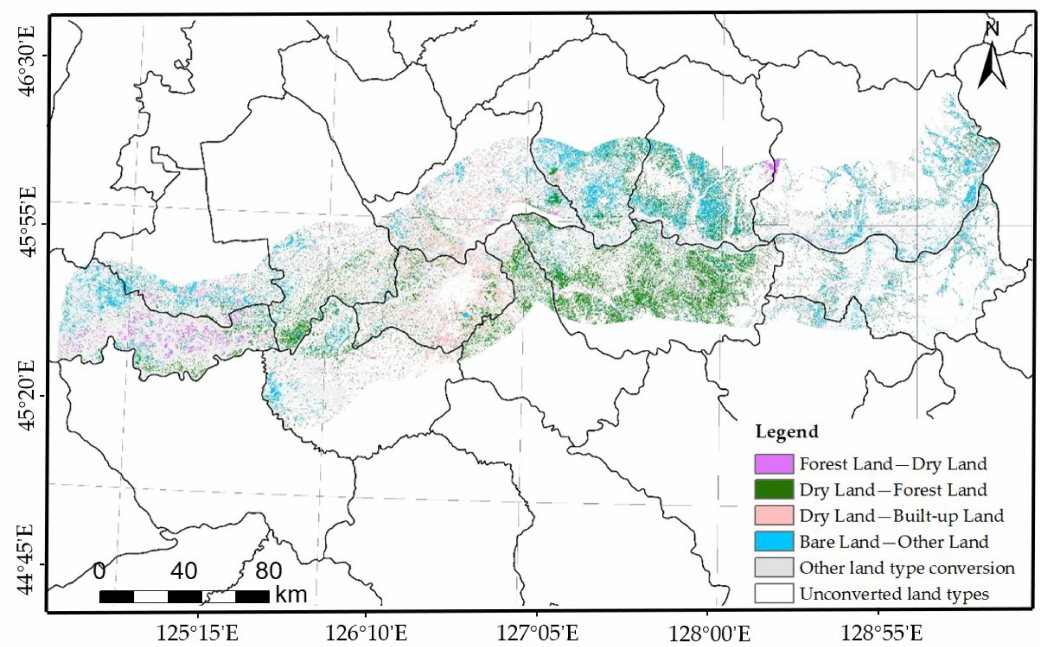
Figure 5. Spatial transfer map of land use types in the buffer zone of the river basin,